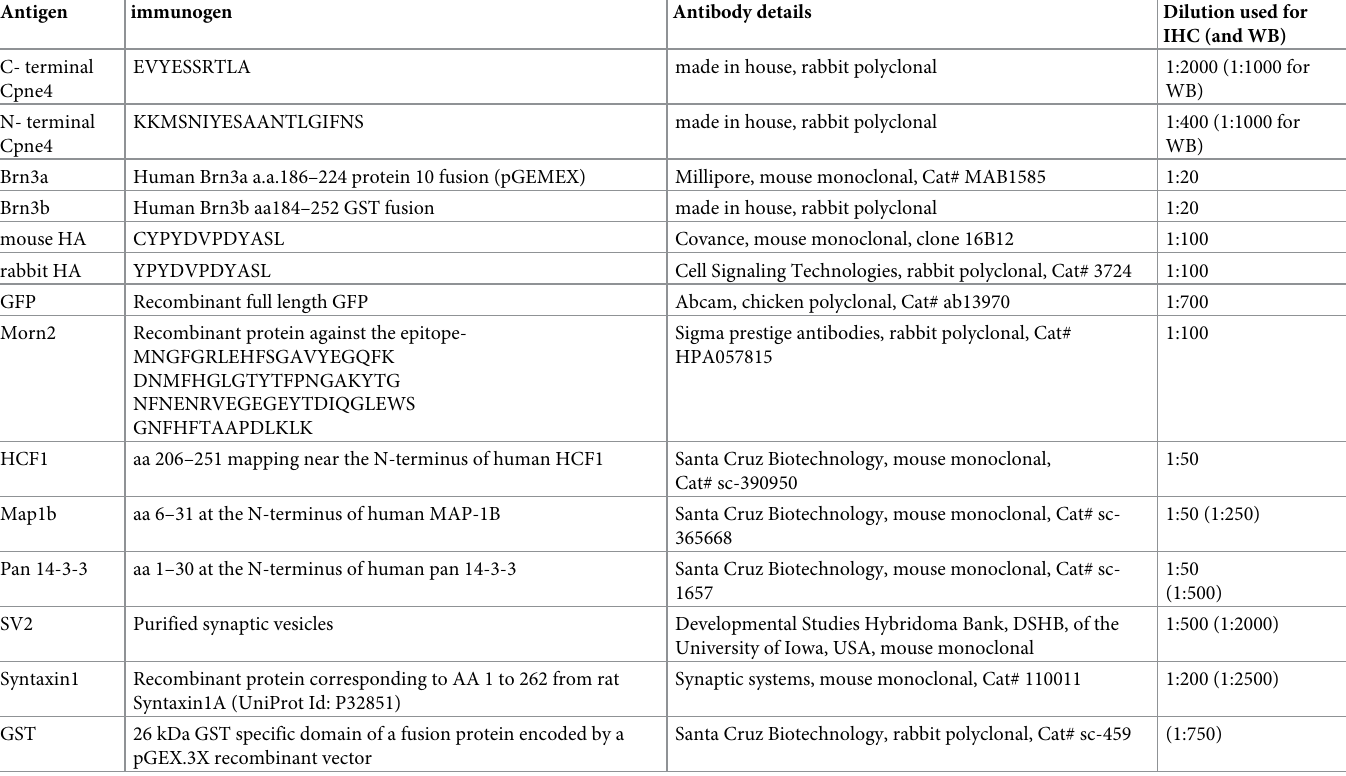
Table 1. List of antibodies used for immunofluorescence and WB. Antigen immunogen Antibody